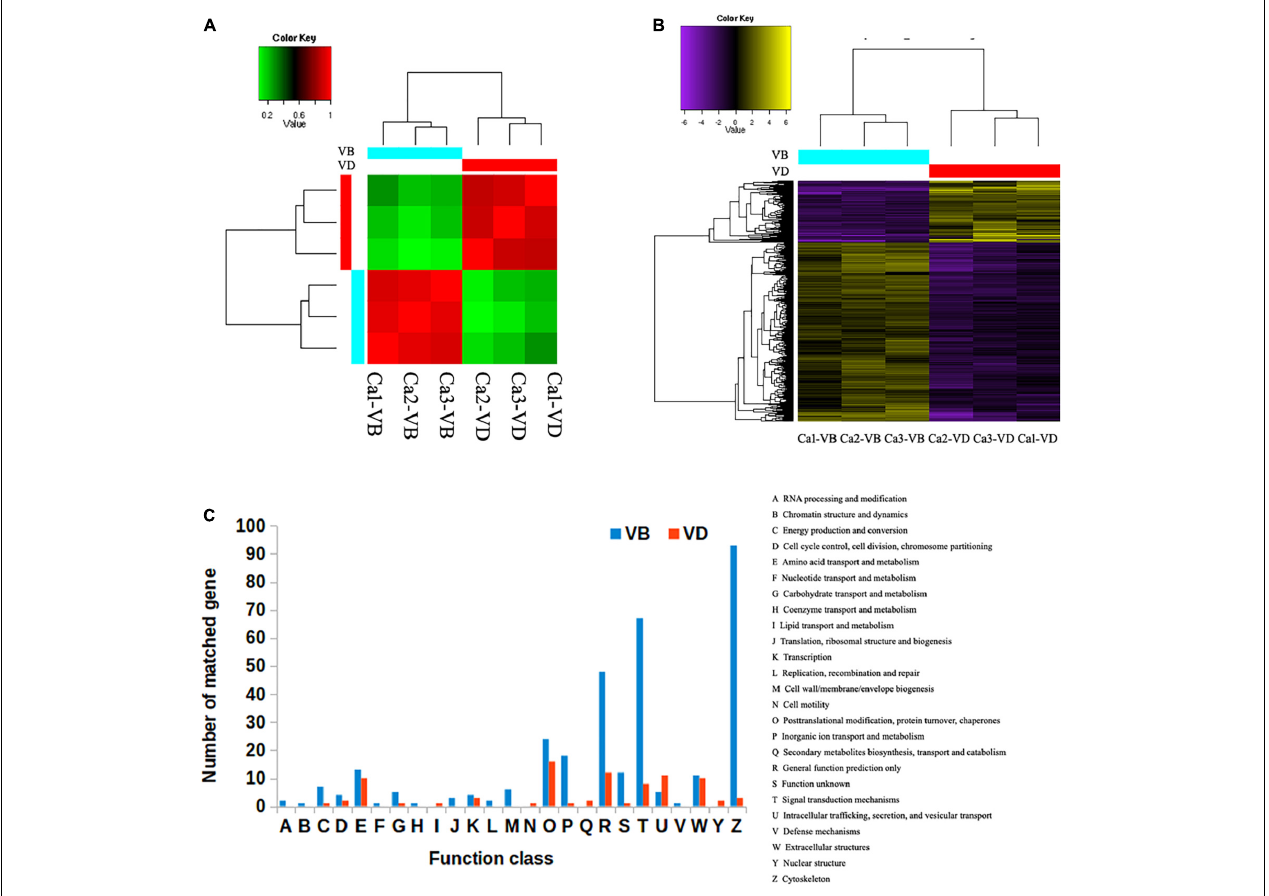
FIGURE 1 | The differentially expressed genes between venom duct (VD) and venom bulb (VB). (A) , Sample correlation matrix. (B) , Heatmap of differentially expressed genes. (C) , KOG annotations of differentially expressed transcripts between the venom ducts and venom bulbs of C onus. caracteristicus